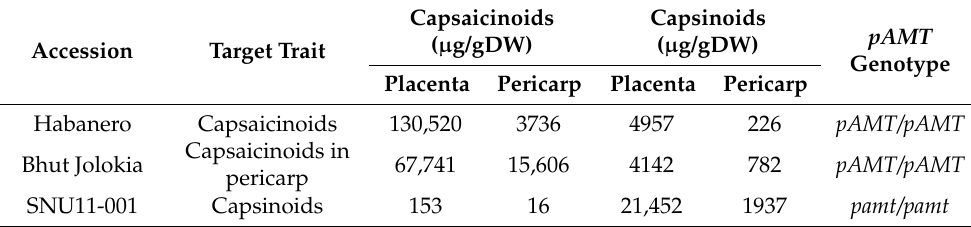
Table 1. Capsaicinoid and capsinoid contents of three accessions.